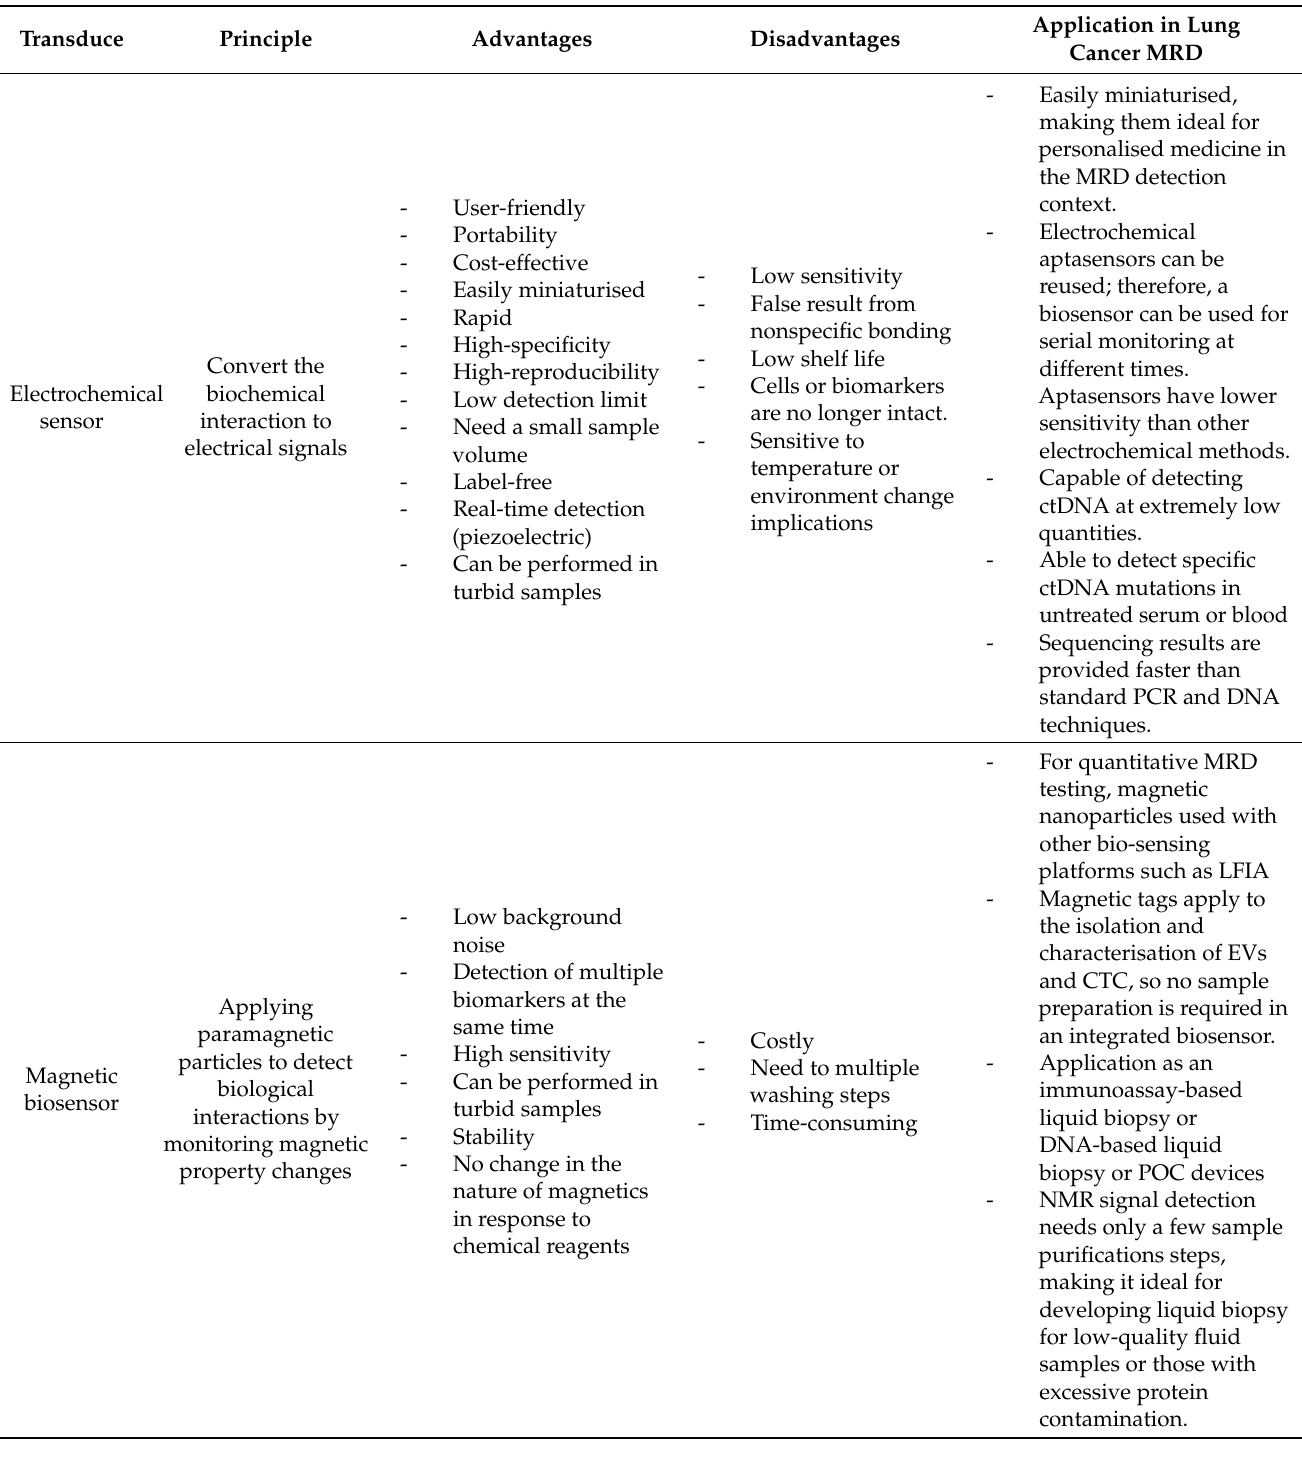
Table 3. Comparison of different biosensors used to diagnose MRD liquid